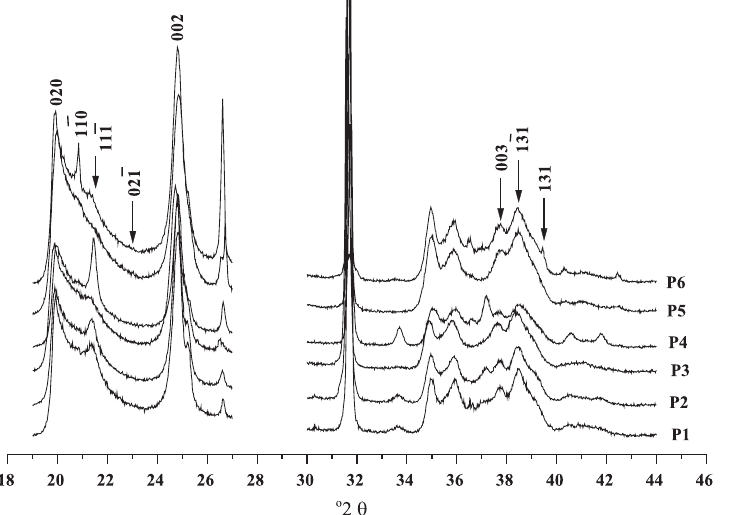
Figura 2. Difratogramas de raios X da fração argila de horizontes coesos (P1 a P5) e não-coeso (P6) de solos provenientes dos sedimentos do Grupo